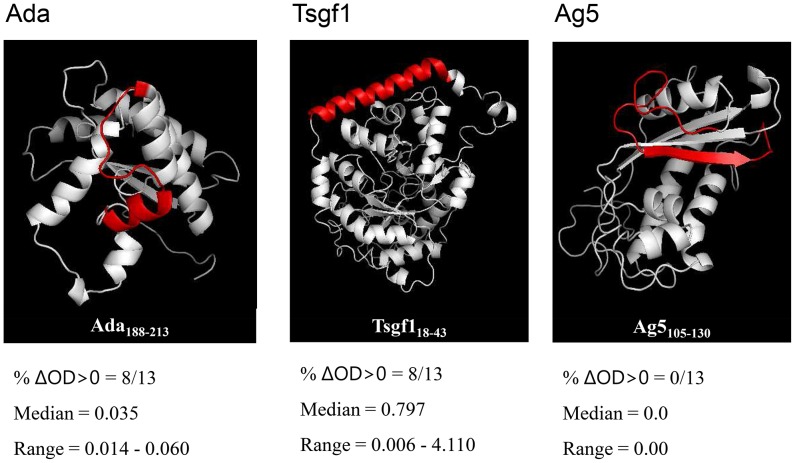
3D models of the Ada, Tsgf1, and Ag5 Glossina salivary proteins.3D structure models were realized with Phyre and verified with molProbity server. The position of each selected candidate peptide is highlighted in red. Each peptide was evaluated in an ELISA indirect immunoassay against 13 plasma samples previously shown to react strongly with Glossina palpalis gambiensis whole saliva extracts [23]. Results are expressed in terms of number of plasma samples with ΔDO>0 and median and range of positive values for each synthetic peptide.